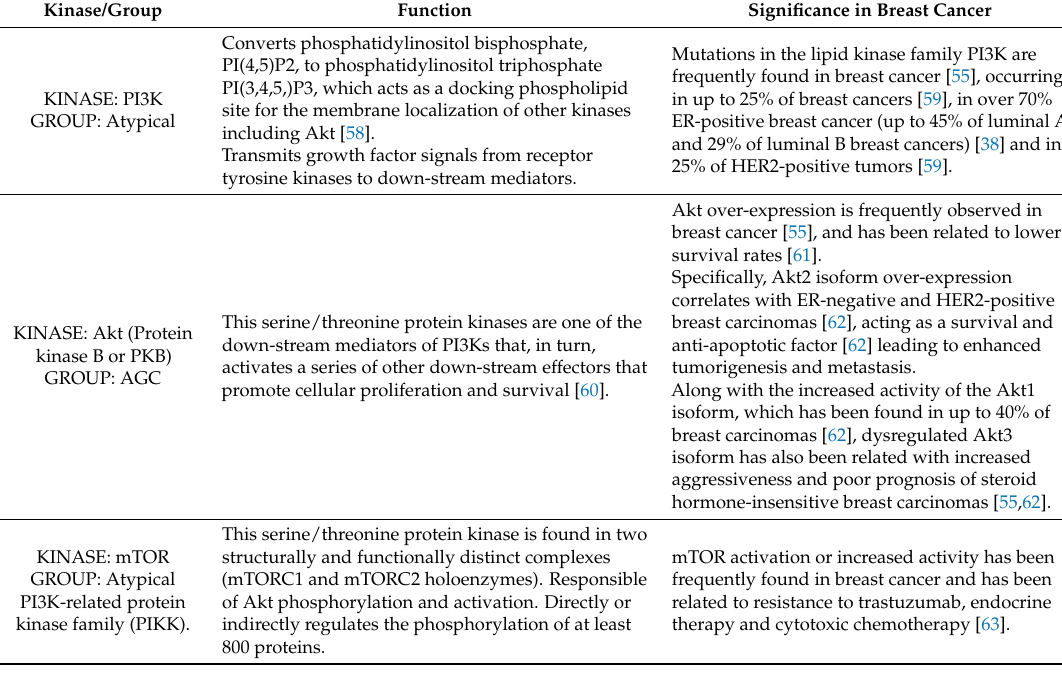
Table 4. Altered phosphatidylinositol-3-kinase (PI3K)/Akt/ rapamycin (mTOR) pathway kinases and significance in breast